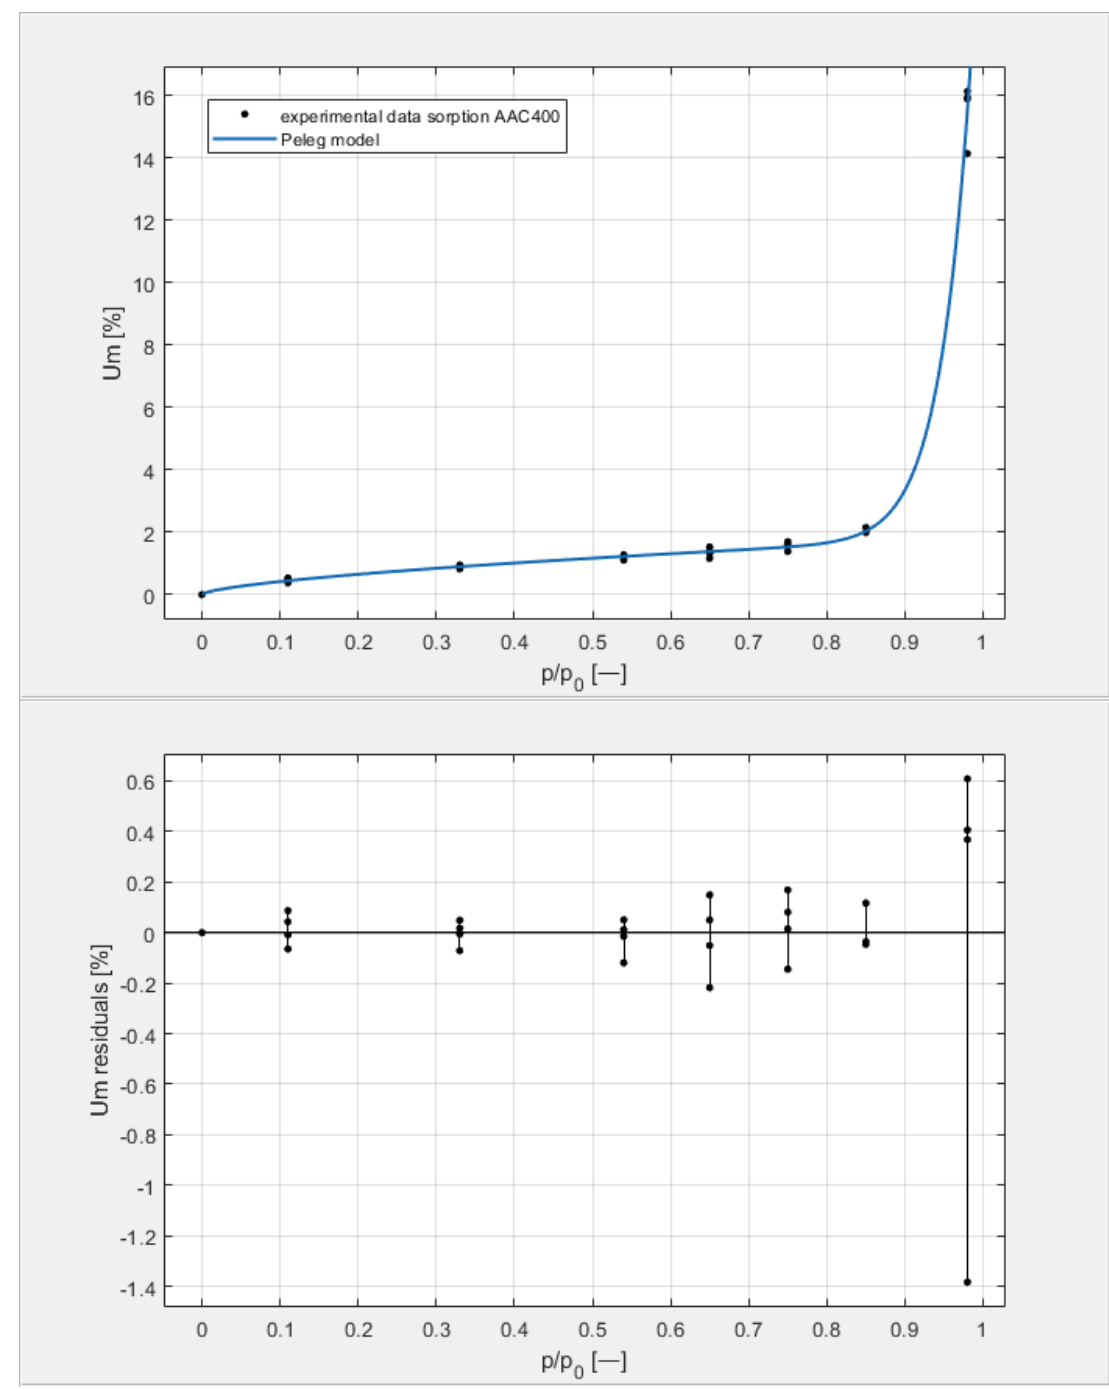
Figure 9. The sorption isotherms of class 400 aerated concrete described by the Peleg equation, plotted with the approximation error.